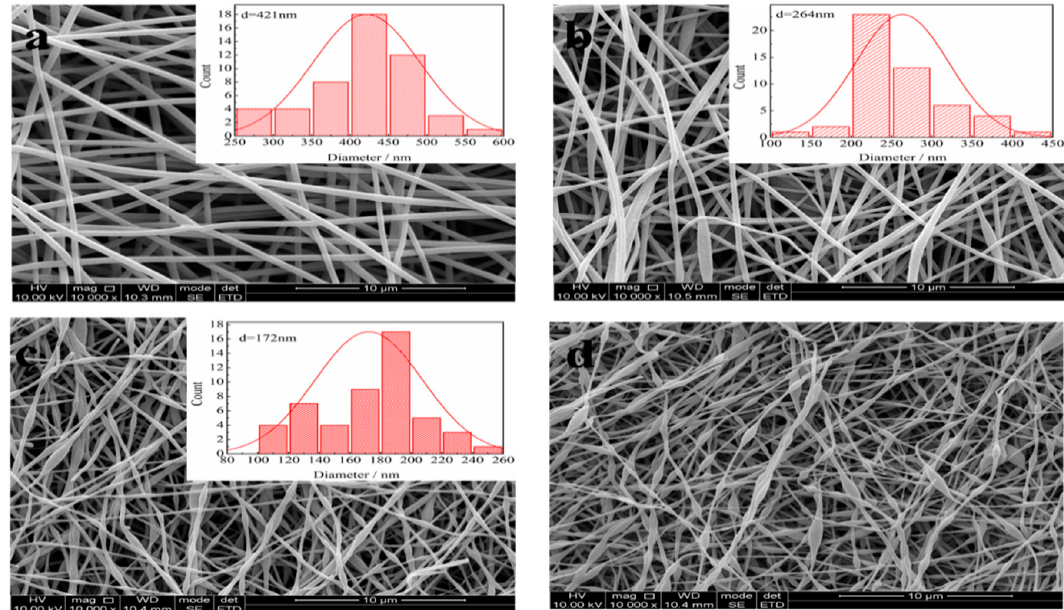
Figure 2. SEM images of different ECNF membranes: ( a ) ECNFs-0; ( b ) ECNFs-4; ( c ) ECNFs-6; and ( d ) ECNFs-7.